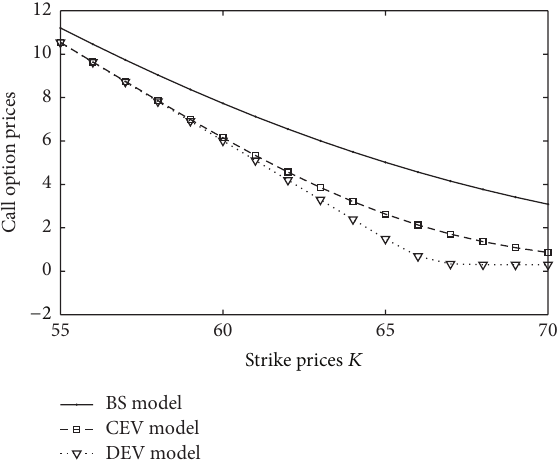
Figure 8: Call option prices at 𝑆 0 = 65 during Asian